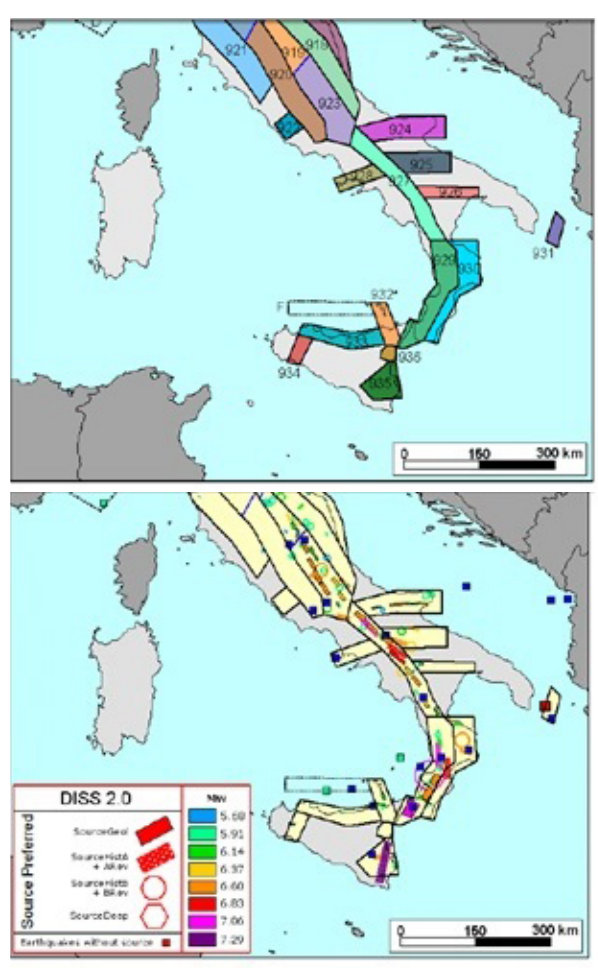
Fig. 4. Seismogenic map of the Southern Italy named ZS9 (OPCM 20.03.2003 n.